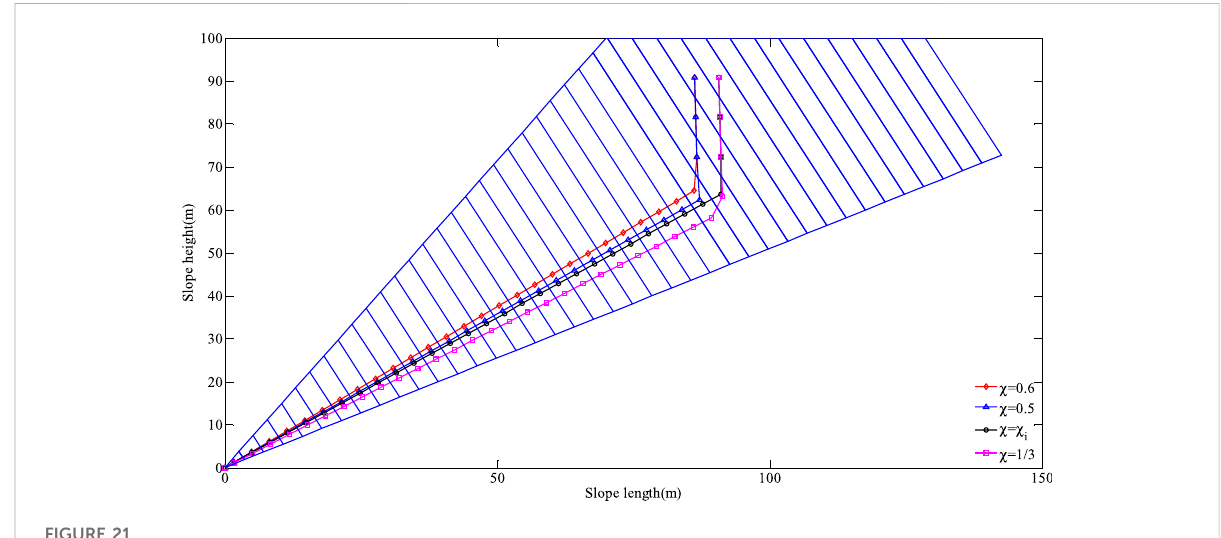
FIGURE 21 Slope failure surfaces obtained through the presented framework for different values of χ